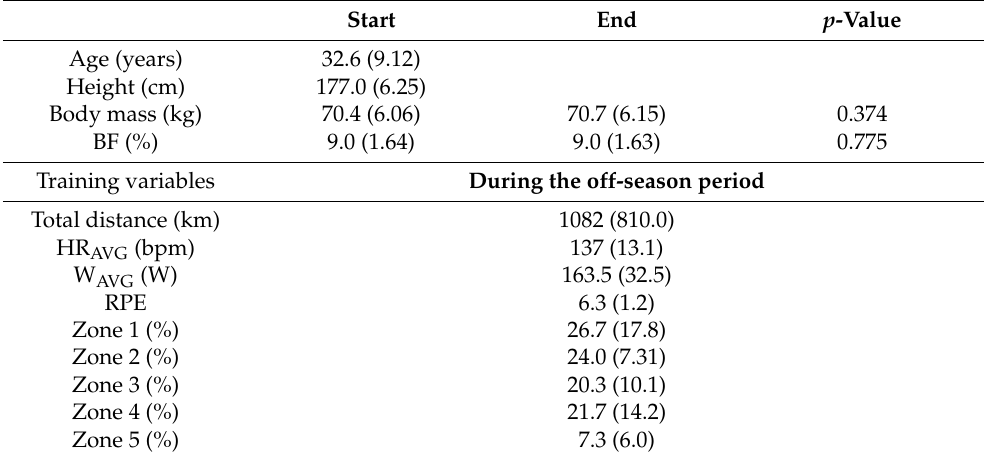
Table 1. Baseline general characteristics and training variables of well-trained cyclists during the off-season period.